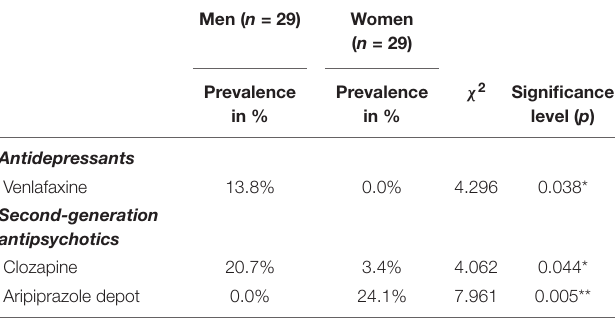
TABLE 6 | Prescription rates of drugs frequently prescribed in male and female in-patients with